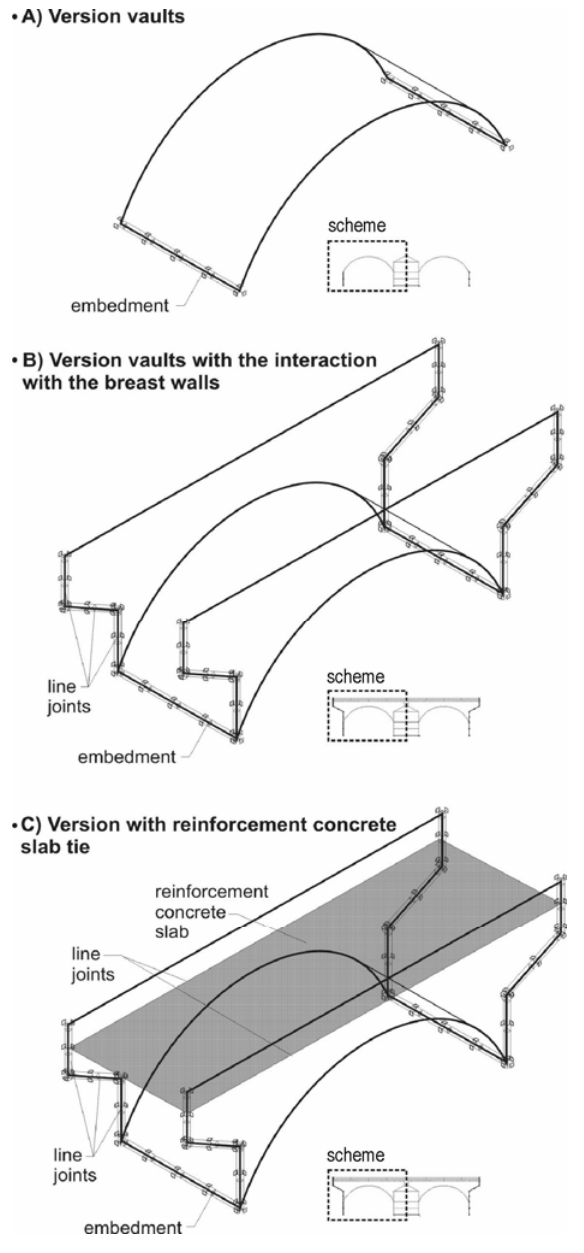
Fig 4. Scheme of investigated models of stone bridge